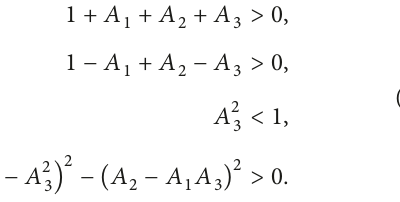
Figure 1: Bifurcation diagram for system (10) with respect to the parameter: (a) 𝑘 1 and the values of the other parameters are fixed, 𝑘 2 = 4 , 𝑘 = 5 , 𝑐 = 0.19 , 𝑐 = 0.18 , and 𝑐 3 1 2 𝑐 = 0.17 3